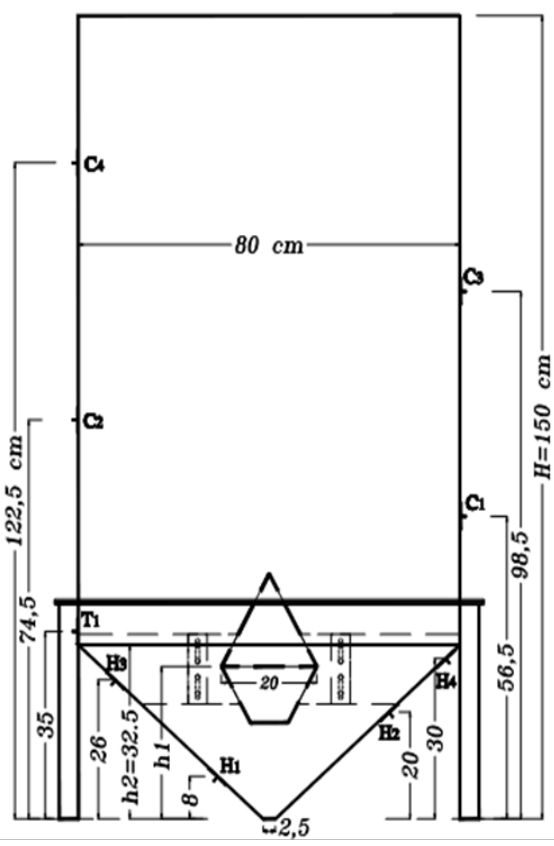
Fig. 4 The Insert positions and the levels of the pressure transducers.